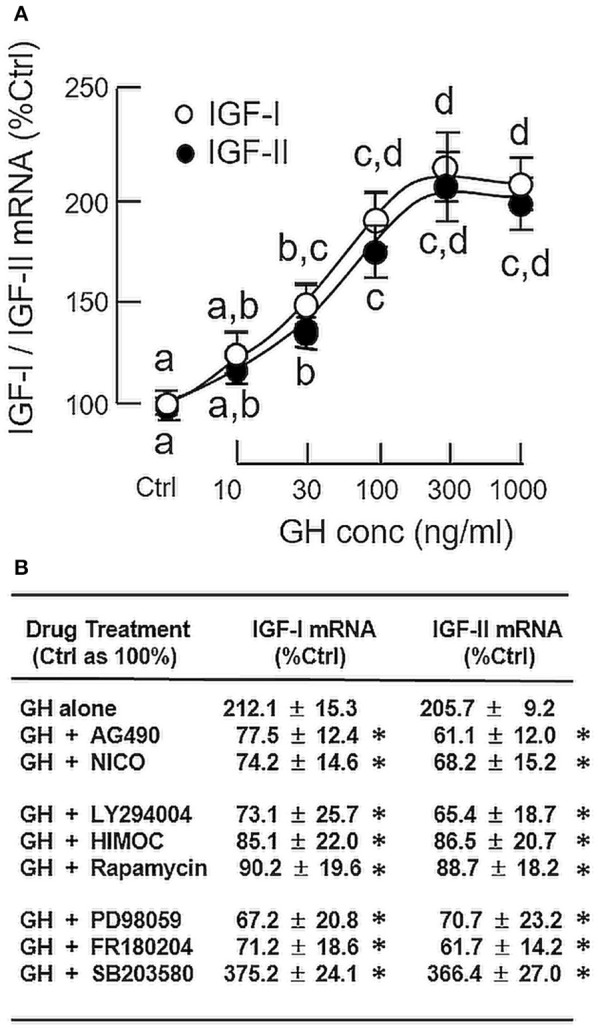
Regulation of IGF-I and -II expression by GH in grass carp hepatocytes. (A) Effects of increasing doses of GH treatment (10–1,000 ng/ml) on IGF-I and -II mRNA expression. (B) JAK2/STAT5, MAPK, and PI3K/Akt pathways in IGF-I and -II mRNA expression induced by GH. For dose dependence experiment, static incubation of hepatocytes was conducted for 24 h with increasing levels of GH as indicated. For parallel experiments to examine the signal transduction involved in GH actions, hepatocytes were treated for 24 h with GH (300 ng/ml) in the presence of the JAK2 inhibitor AG490 (20 μM), STAT5 inhibitor NICO (20 μM), PI3K inhibitor LY294004 (10 μM), Akt inhibitor HIMOC (10 μM), mTOR inhibitor rapamycin (20 nM), MEK1/2 inhibitor PD98059 (10 μM), ERK1/2 inhibitor FR180204 (2 μM), and P38 MAPK inhibitor SB203580 (5 μM), respectively. After treatment, total RNA was extracted from the cell culture and subjected to real-time PCR with primers specific for grass carp IGF-I and -II, respectively. Parallel real-time PCR for 18S RNA was also conducted to serve as the internal control. For IGF data presented (Mean ± SEM), the groups denoted by different letters (for dose dependence) or with asterisks (for signal transduction) represent a significant difference at P < 0.05.